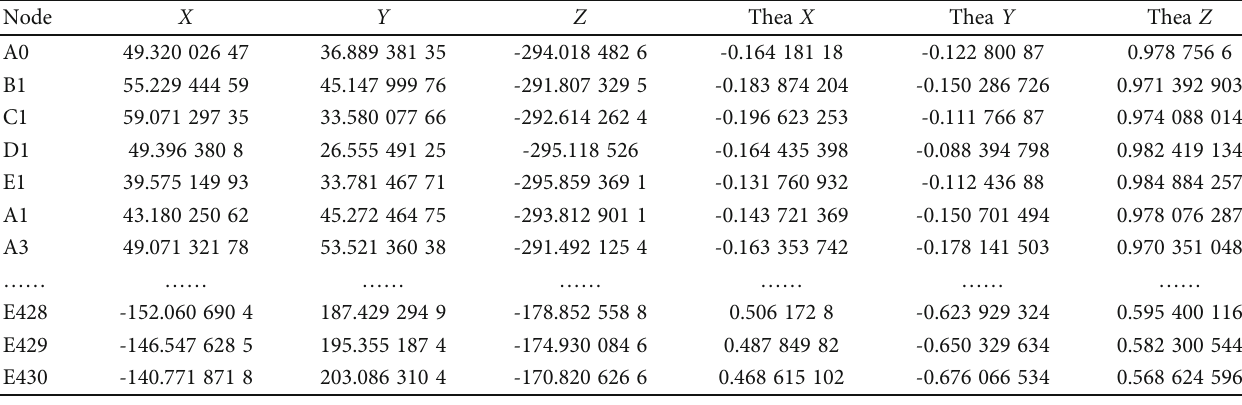
Table 2: Coordinates of each main cable node after rotation.